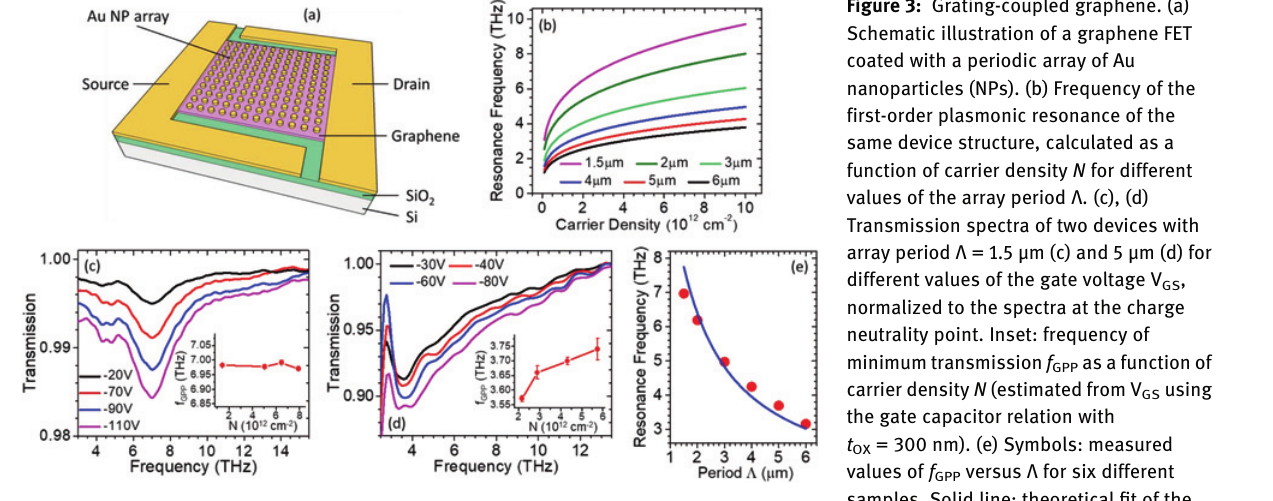
values of f GPP versus Λ for six different samples. Solid line: theoretical fi t of the